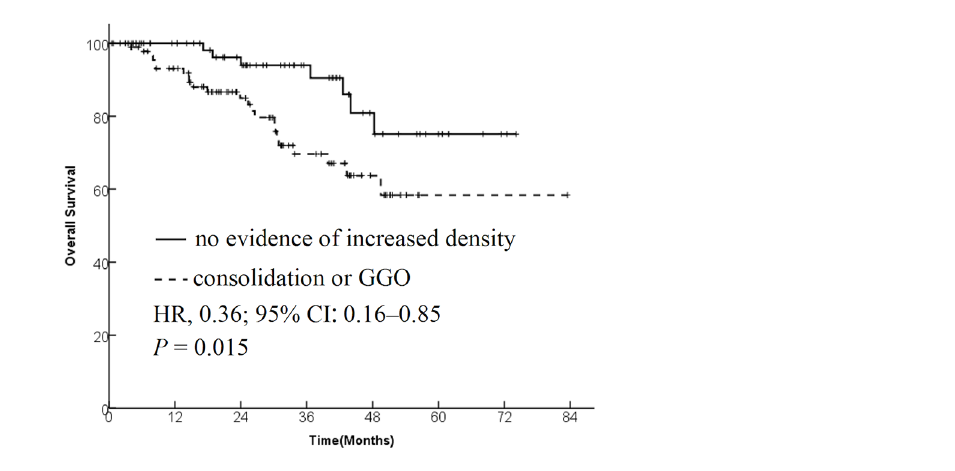
FIGURE 1 | Kaplan – Meier curves for overall survival.